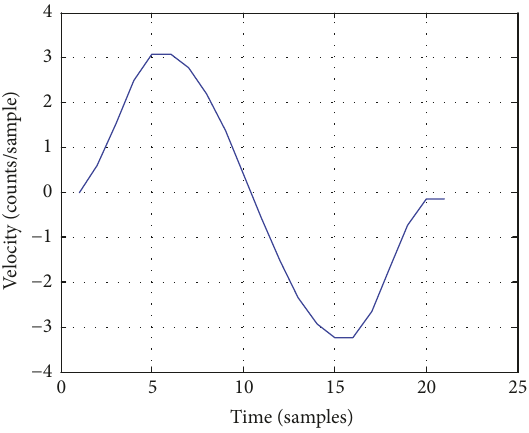
Figure 6: The velocity waveform of PMSM in discrete case.